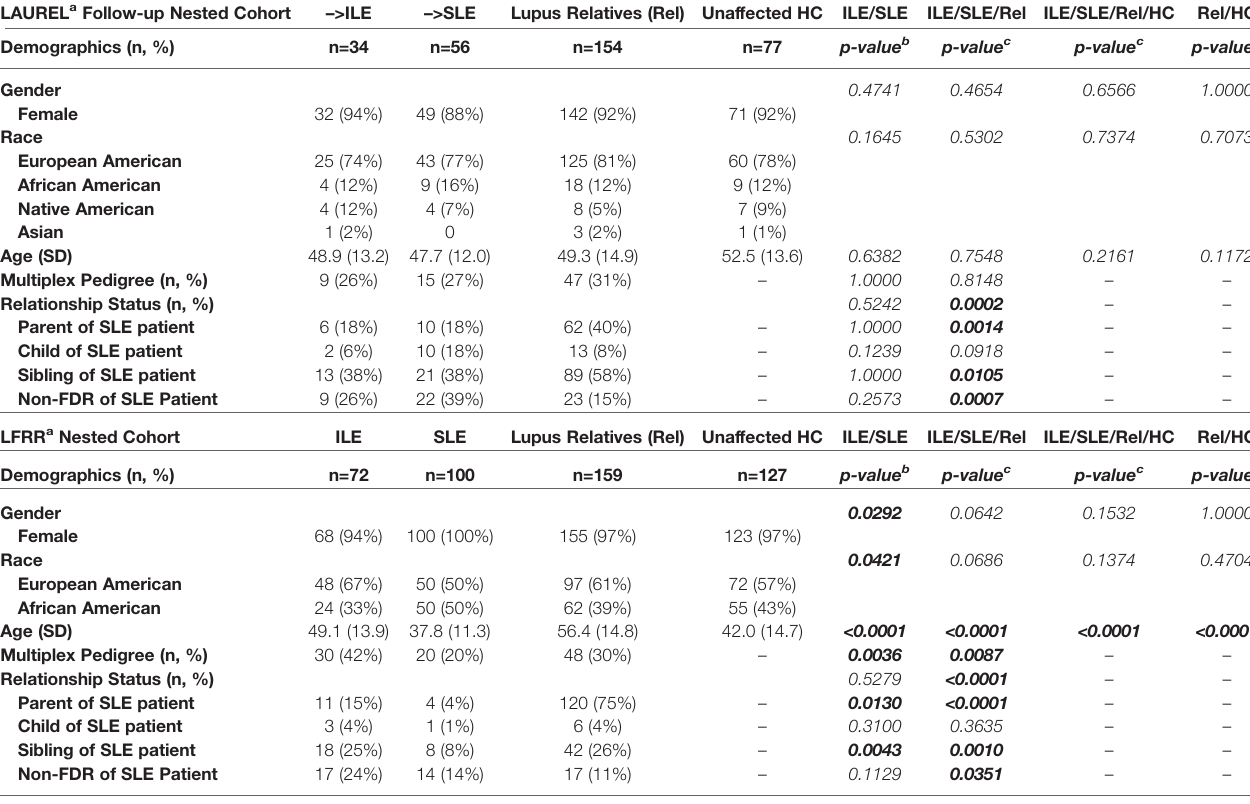
TABLE 1 | Demographic Characteristics of Nested Lupus Relatives